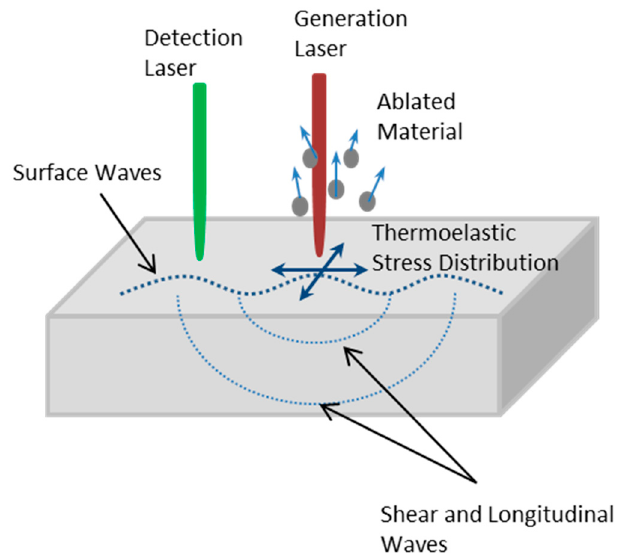
Figure 9. Schematic for laser ultrasound inspection setup (Image courtesy EWI).